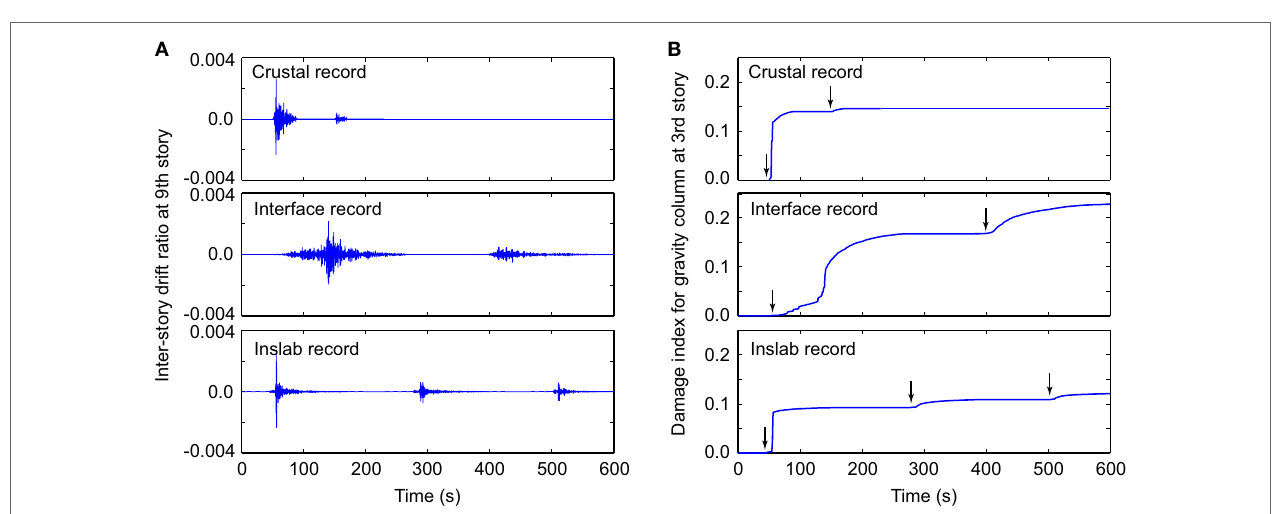
FIGURE 5 | Sample time histories of structural responses subjected to three ground motion records (crustal, interface, and inslab; same records shown in Figures 1B): (A) interstory drift ratio at the ninth story and (B) damage index for gravity column at the third story .